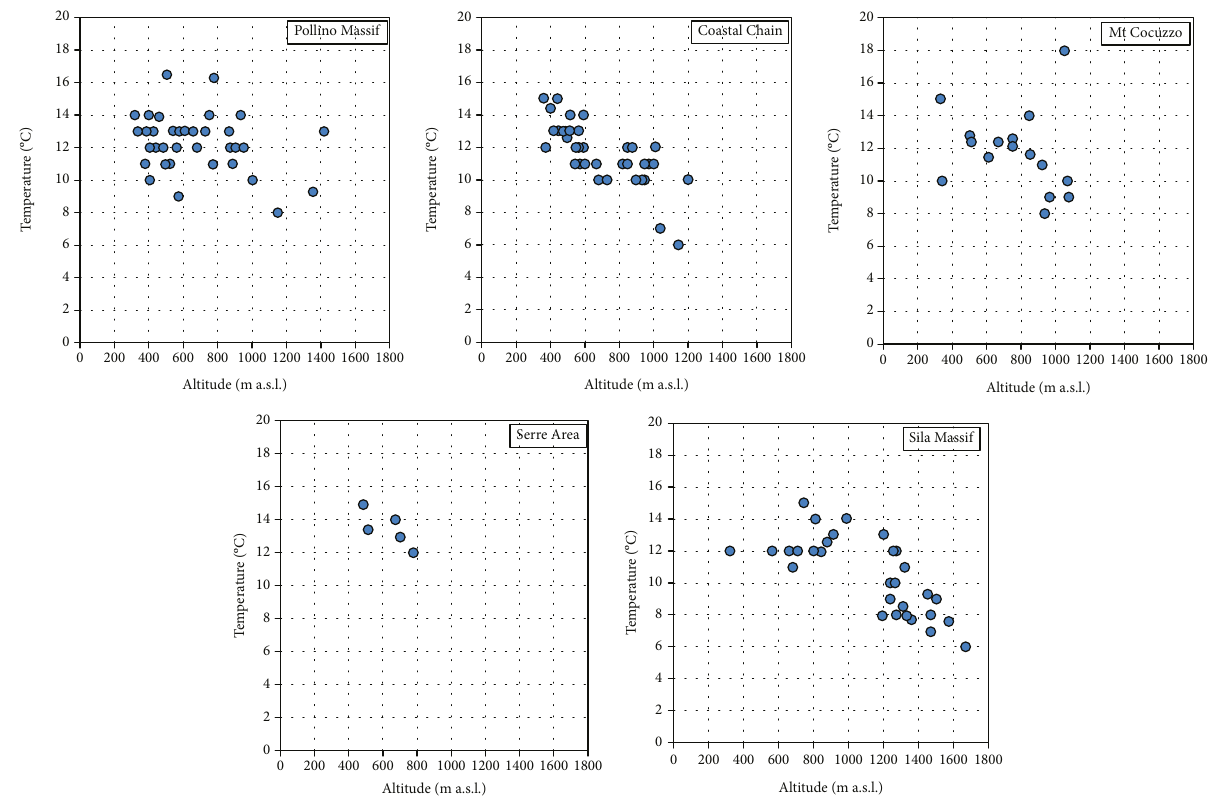
Figure 4: Relationship between spring water temperature and